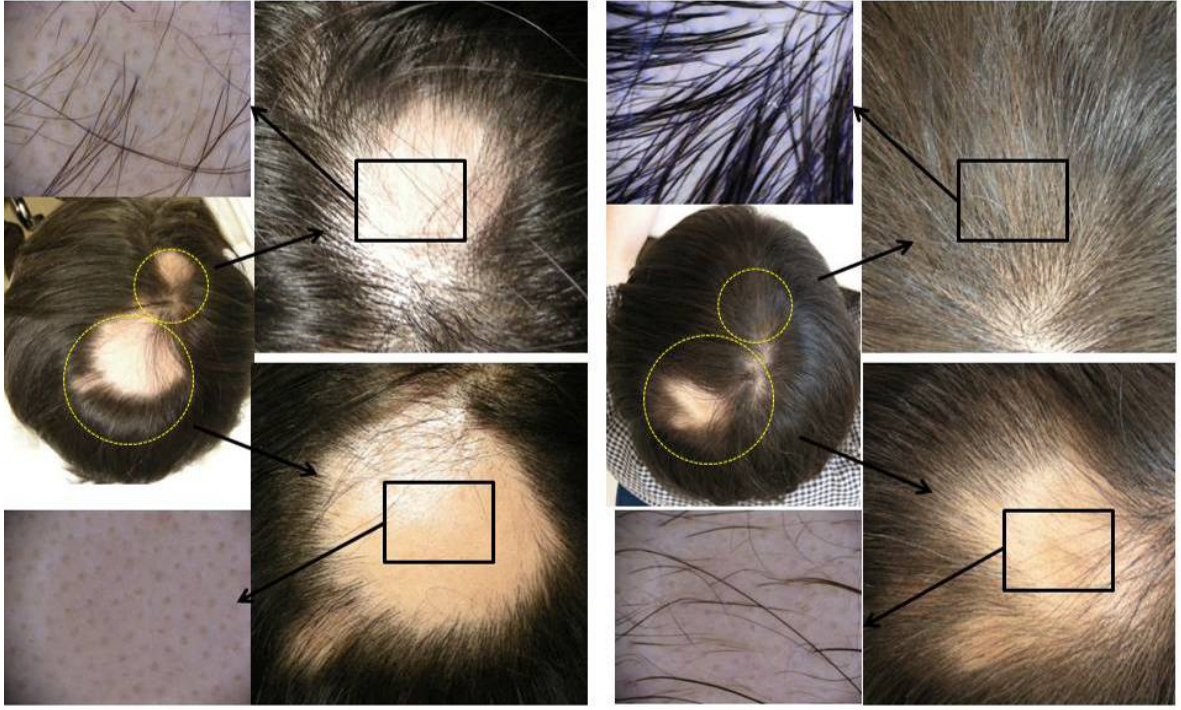
Figure 4. PRP-containing LMW-H/P MPs treatment for alopecia